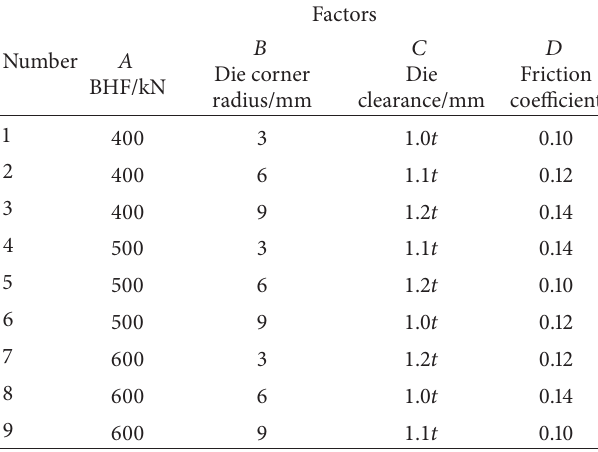
Table 3: Scheme of orthogonal